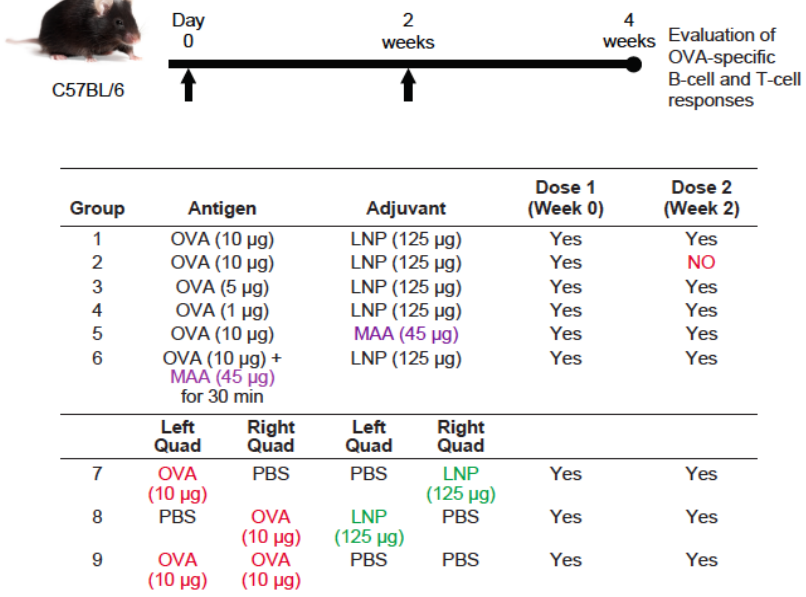
Figure 3. HBsAg-specific T-cell responses in BALB/c Mice. Spleens from five randomly selected mice out of ten immunized mice/group were collected, pooled, and processed two weeks after final vaccination. ( A ) The total HBsAg-specific T-cell response was evaluated using the IFN-γ ELISPOT assay to determine IFN-γ producing spots per million (SFU) splenocytes; or ( B ) HBsAg-specific CD4+